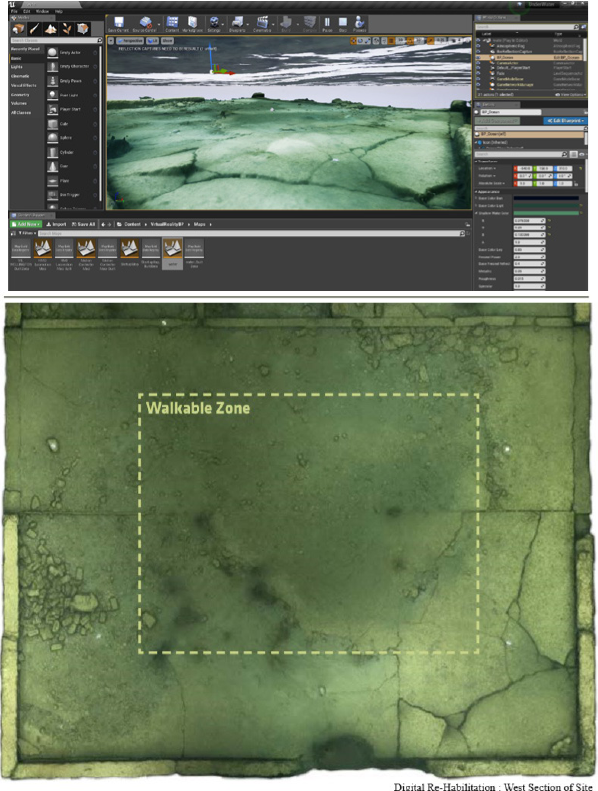
Figure 12. VH Experience: The Digital Restitution of Lot